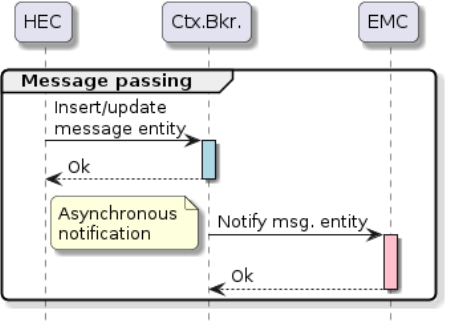
Figure 11. Orchestration asynchronous message